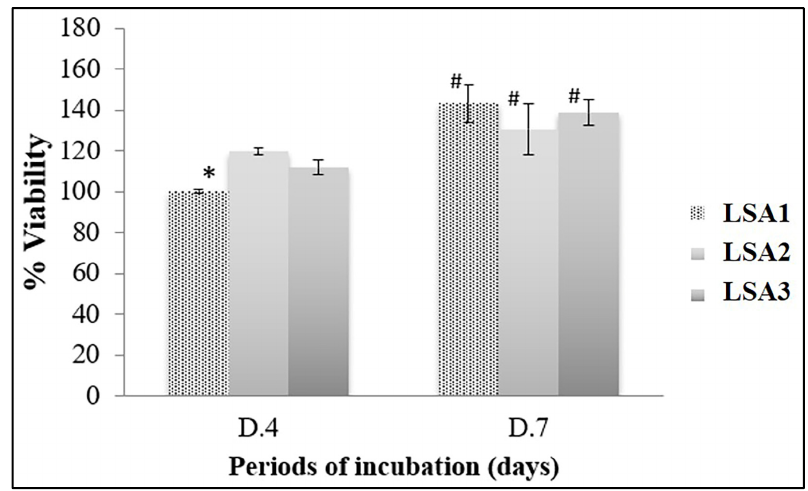
Figure 7. Viability and proliferation of MG-63 cells. Lithium disilicate glass-ceramics with various Al 2 O 3 were assessed in terms of biocompatibility with MG-63 cells using MTT assay for 4 (D.4) and 7 days (D.7). The results were from a triplicate ( n = 3) experiment and the statistical difference was tested when p < 0.05, which is represented by * (among the material types in each investigation period) and by # (between two investigation periods among the same material types).